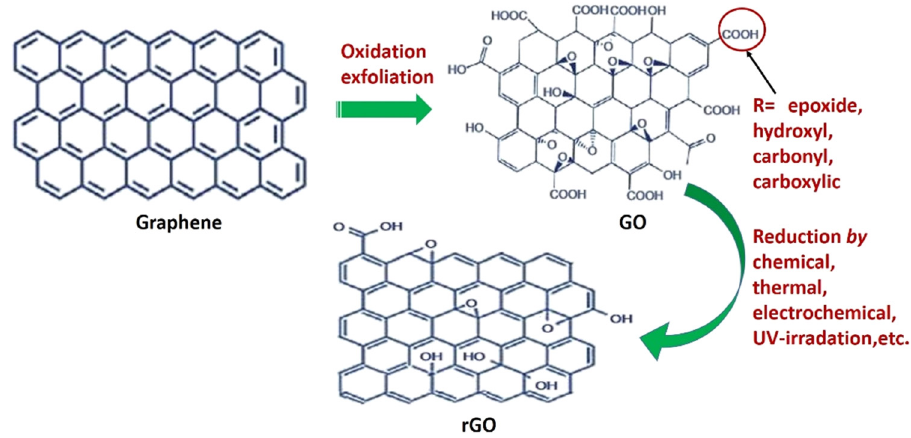
Figure 2: Schematic illustration of routes for preparation of GO and rGO. Adapted from ref. [ 24 ] .